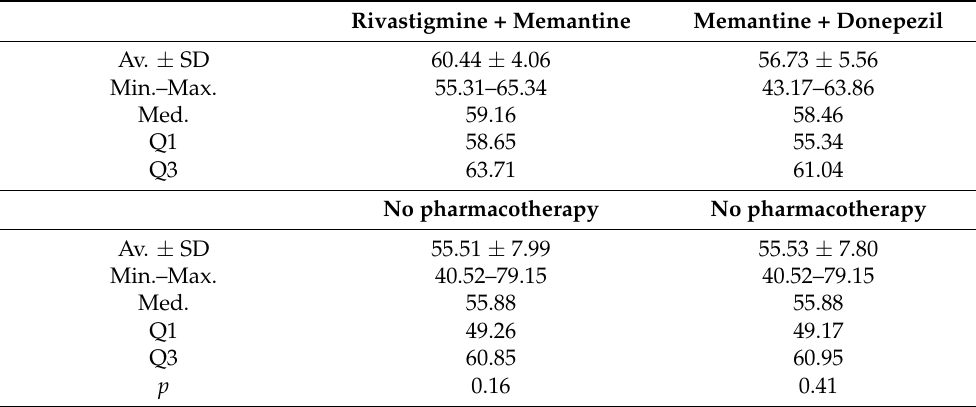
Table 4. UCHL1 concentration [ng/mL] depending on pharmacotherapy.